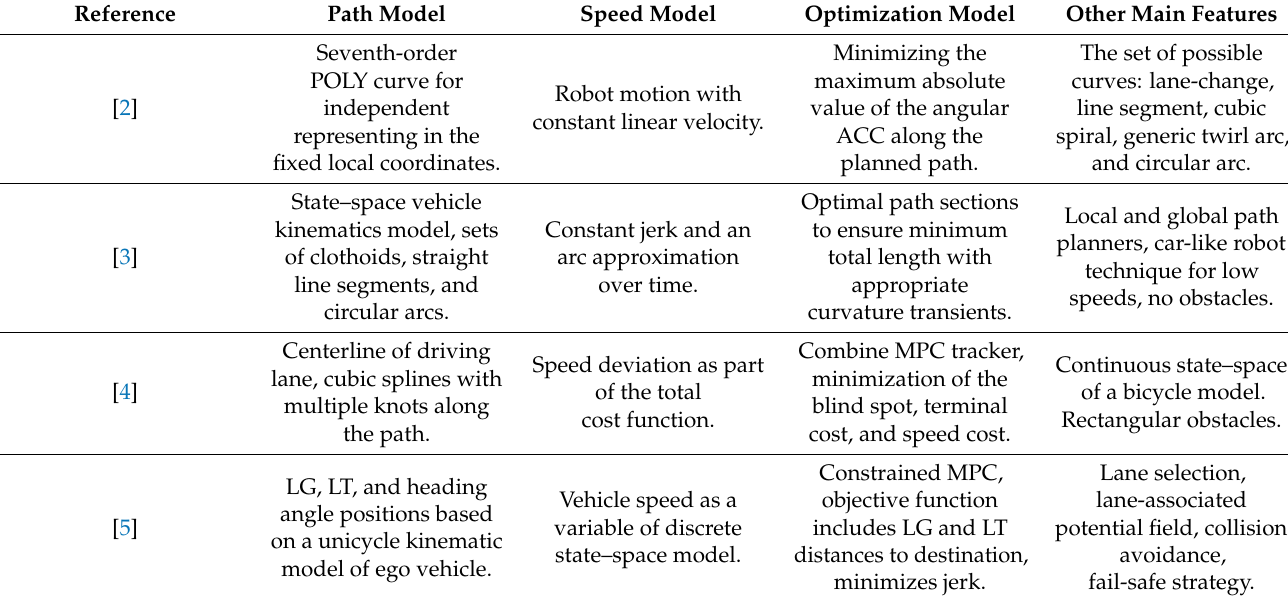
Table 1. Characteristics of selected studies on planning AV motion a